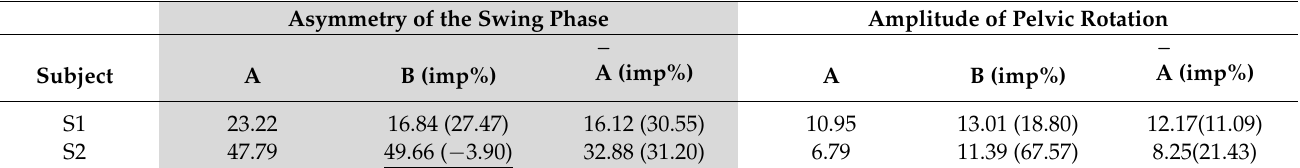
Table 8. Experimental results of the stroke